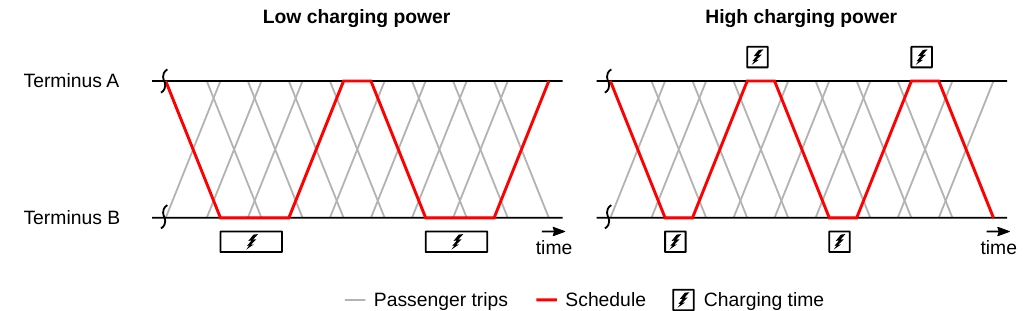
Figure 15. Schematic illustration of the effect of charging power on charging station placement using the greedy scheduling